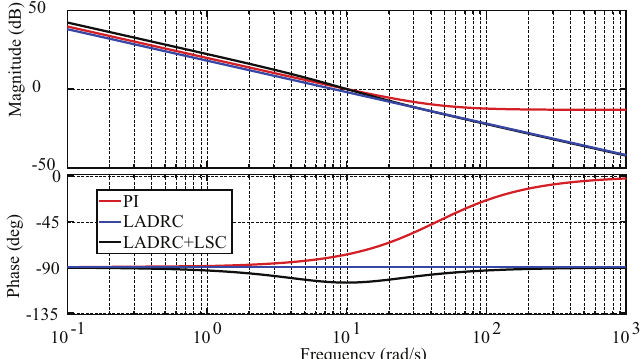
Figure 13. Open loop Bode plot of the developed controllers. Note that the LSC and the LADRC + LSC responses are identical, thus the LSC was not included.